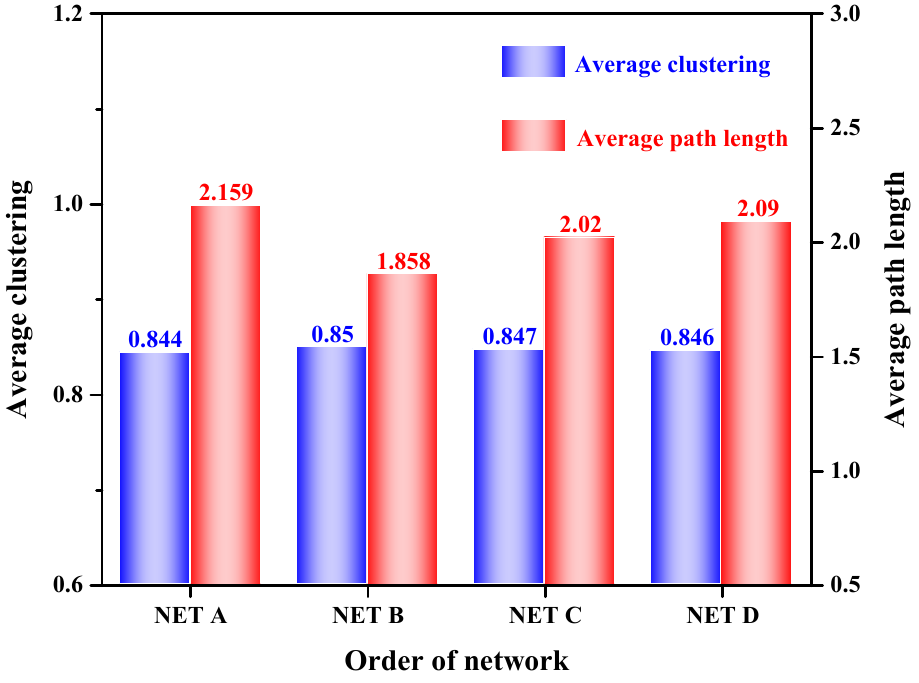
Figure 3. Average clustering coefficient and average path length.